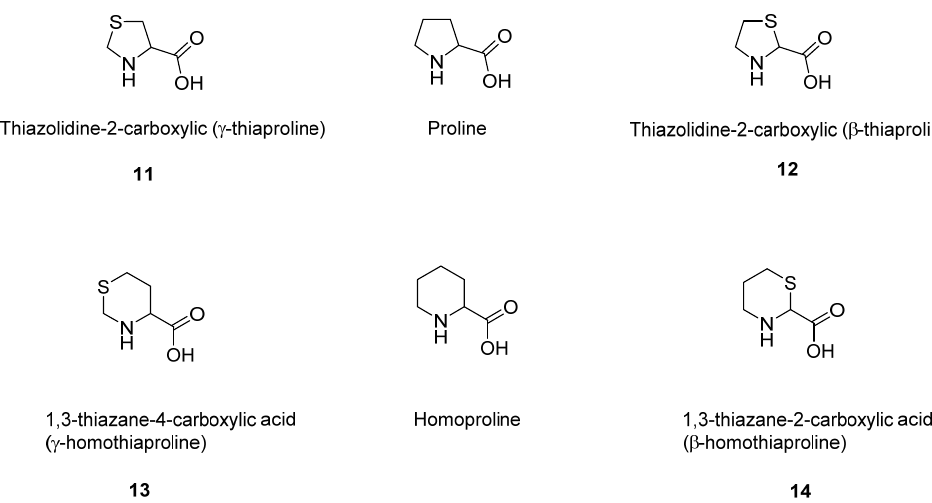
Figure 7. Chemical structures of the sulfur-containing amino acid analogues thiaproline and ho-